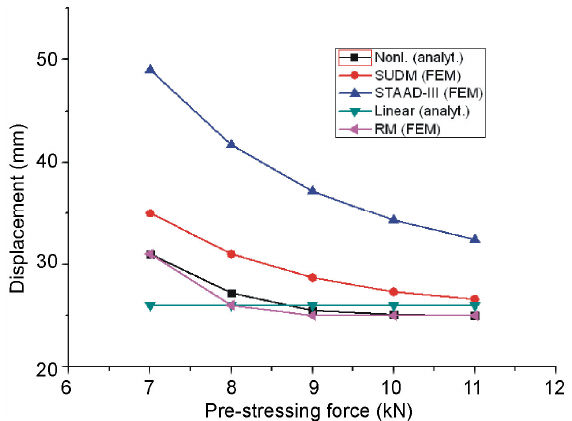
Fig. 3. Graph of mast stem (pole) upper displacement vs pre-stressing force in case of 0,110,7 0 ÷= m H kN